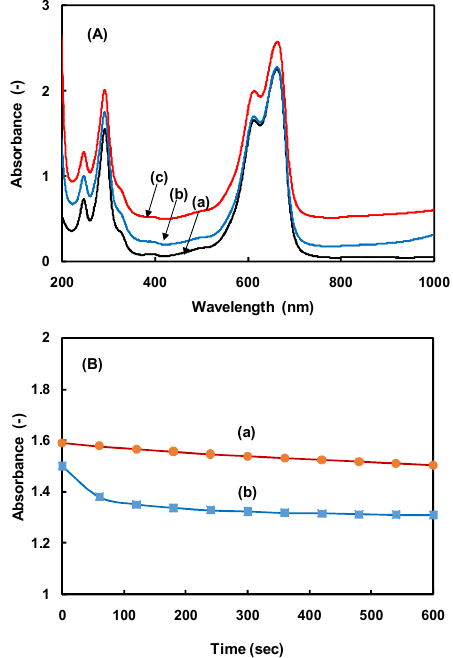
Figure 8. Results of ( A ) UV-vis spectra of as a function of wavelength of ( a ) methylene blue(MB)